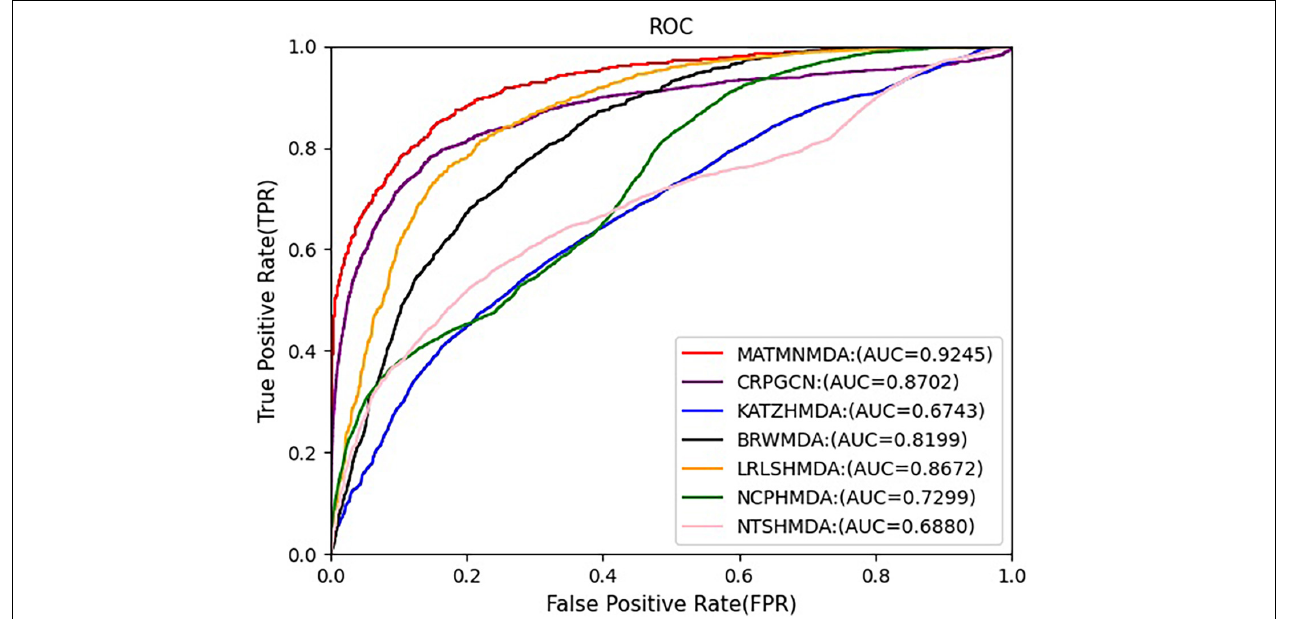
FIGURE 10 | Comparison of AUC for MATMNMDA and baselines on Disbiome dataset.